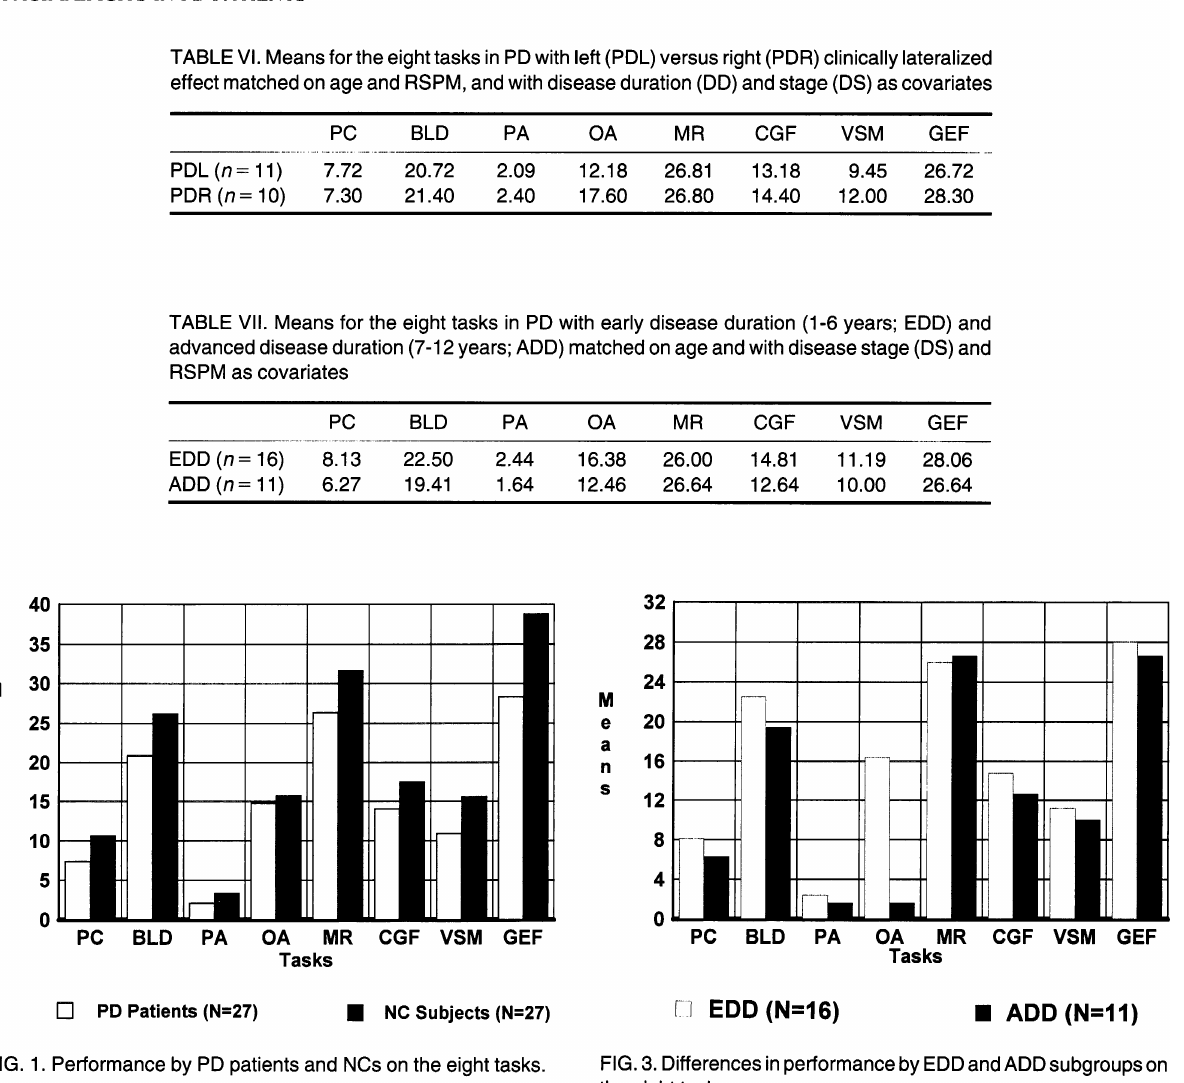
TABLE VI. Means for the eight tasks in PD with left (PDL) versus right (PDR) clinically lateralized effect matched on age and RSPM, and with disease duration (DD) and stage (DS) as covariates